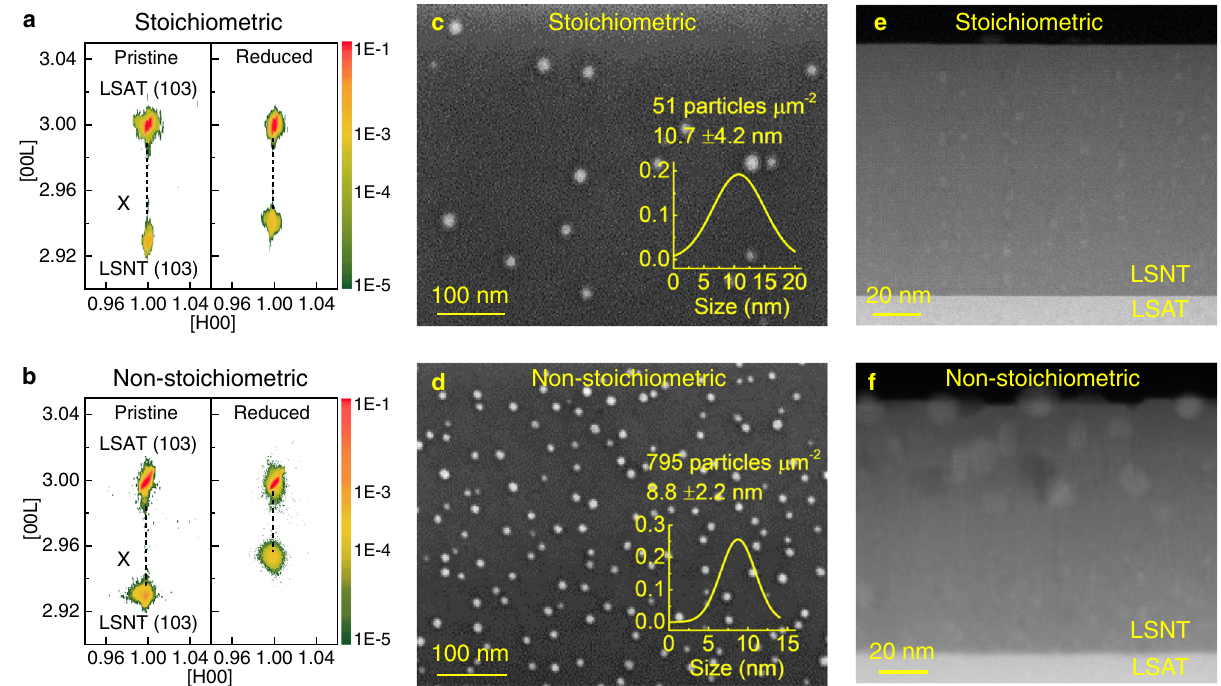
Fig. 1 | Effect of non-stoichiometry of perovskite oxide on NP formation by exsolution. Reciprocal space maps before and after reduction for a the stoichio- metric and b non-stoichiometric LSNT fi lm. The fi lmreduction was performed in a vacuumfurnace(~1×10 − 6 Torr)at900°Cfor10h.All fi lmsshowthatthereciprocal lattice points of fi lm and substrate are aligned along the same [H00], indicating a